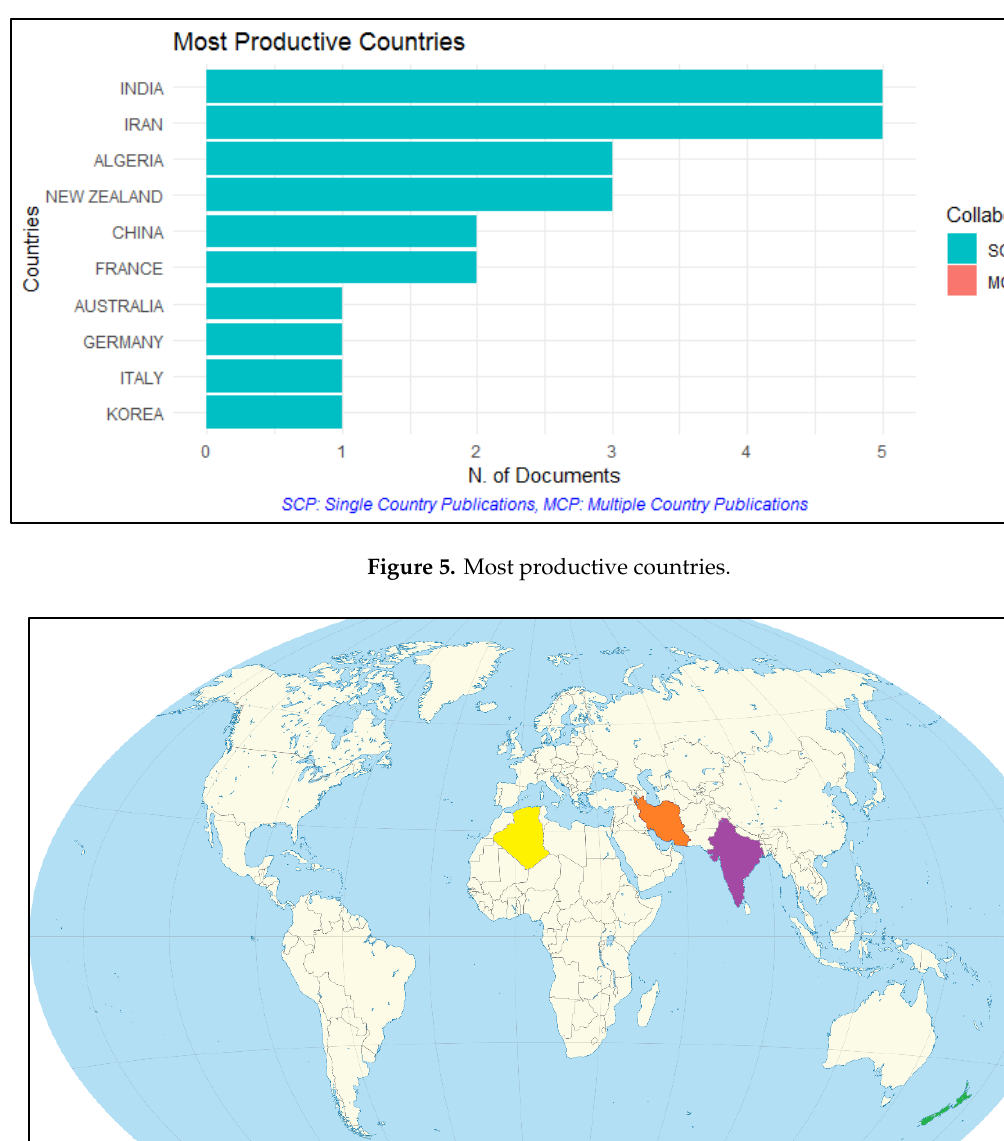
Figure 6. Most Productive Countries in the Map.